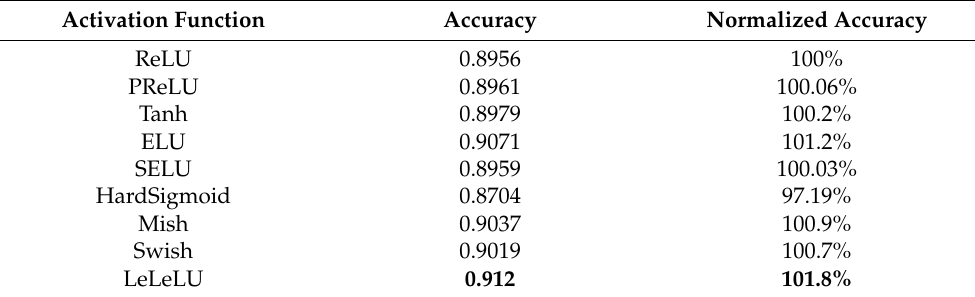
Table 2. Test accuracy in the Fashion MNIST dataset of the activation functions in question, using the corresponding neural network, and accuracy normalized to that attained by ReLU activation